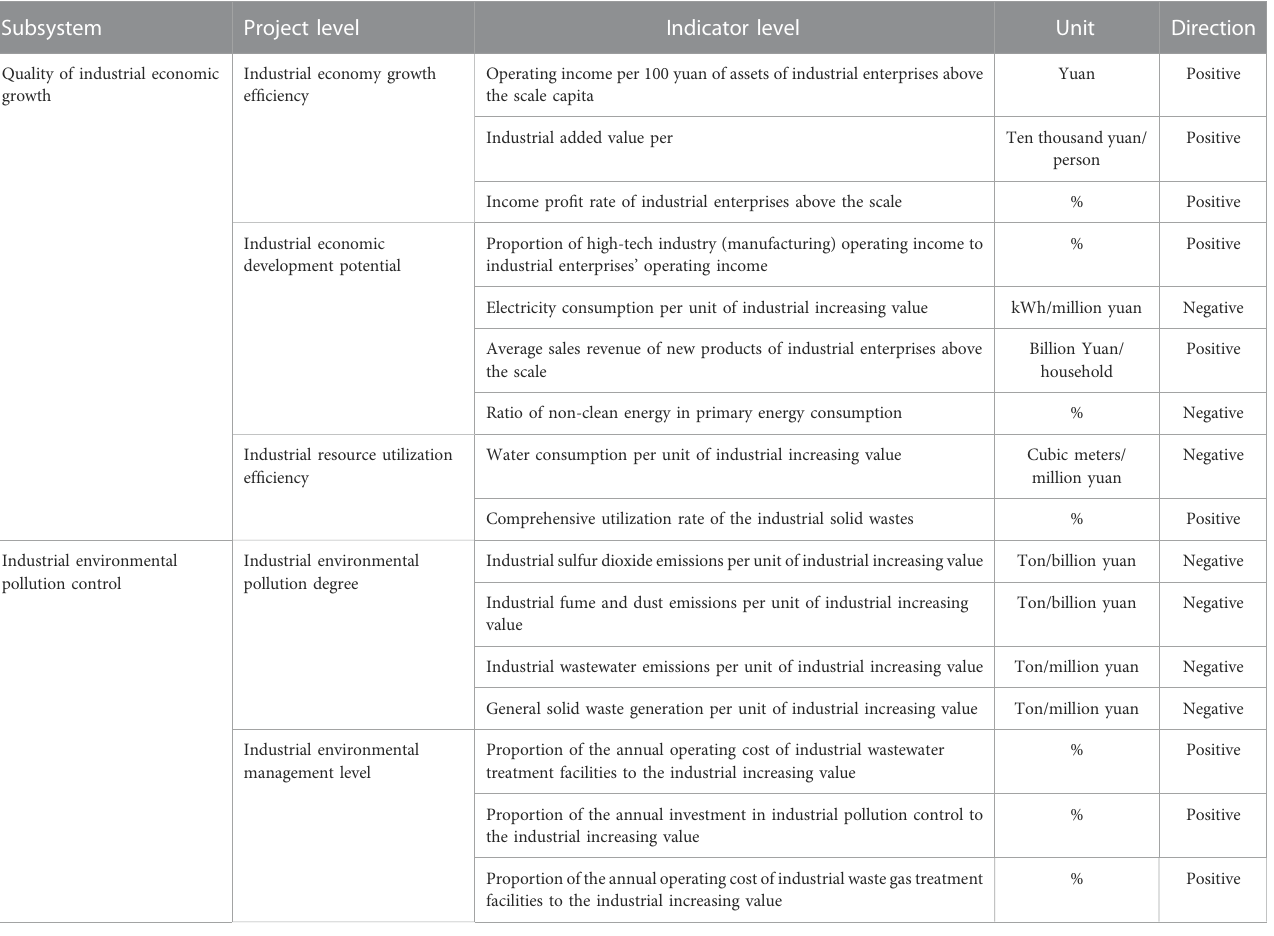
TABLE 1 Green development indicator system of the industry.